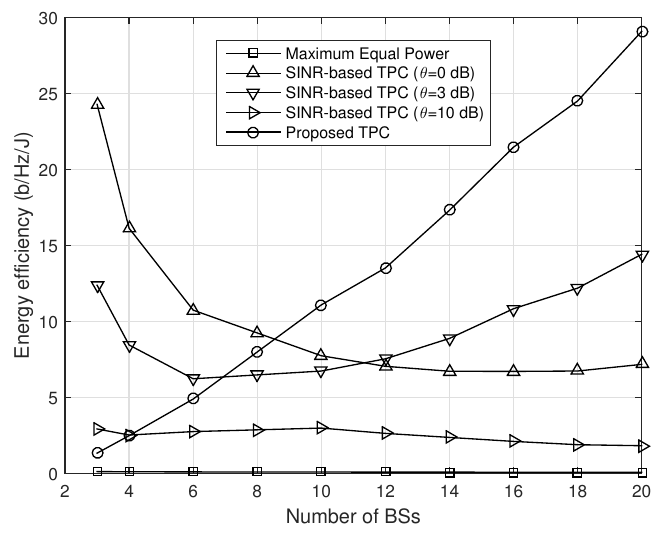
Figure 9. Energy efficiency vs. number of